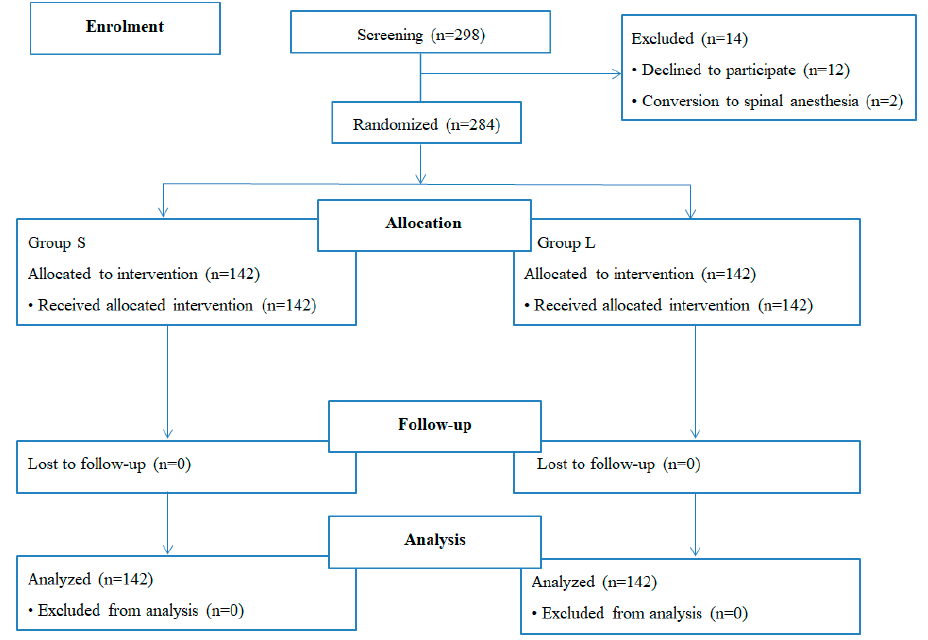
Figure 2. CONSORT diagram for the trial. Table 1. Demographic data and preoperative airway evaluation.